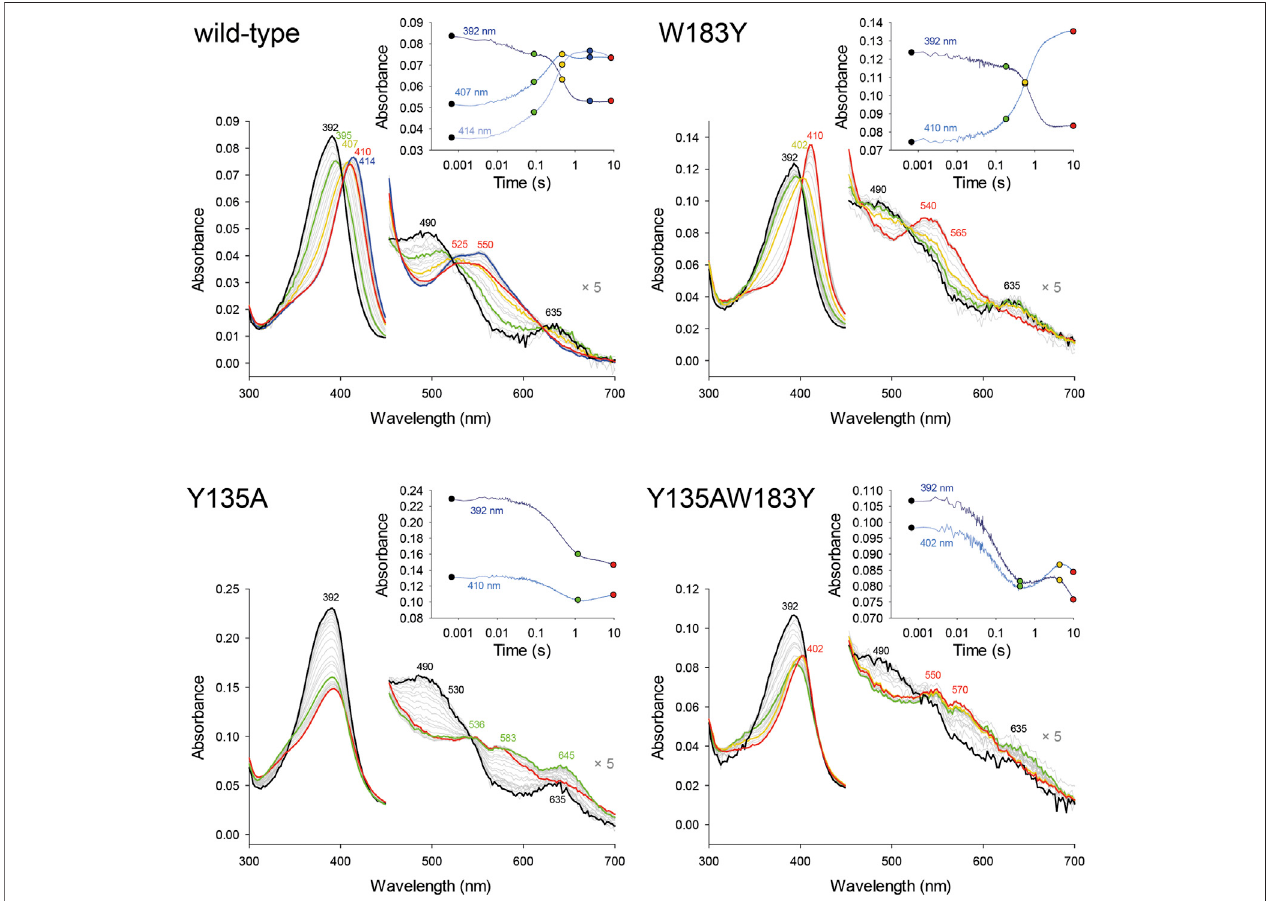
FIGURE 2 | Pre-steady-state kinetics of wild-type Cd ChdC and variants W183Y, Y135A, and W183YY135A reaction with hydrogen peroxide was determined via stopped- fl ow spectroscopy. About 2 – 10 µM coproheme with a 1.5- to 2-fold surplus of protein were mixed with 200 µM H 2 O 2 in 50 mM phosphate buffer of pH 7. Spectra at relevant time points are highlighted in black, green, yellow, or red, and intermediate spectra are shown in light grey. The insets show absorbance changes at indicated fi xed wavelengths over the time and exact corresponding time points to the highlighted spectra are indicated as dots.